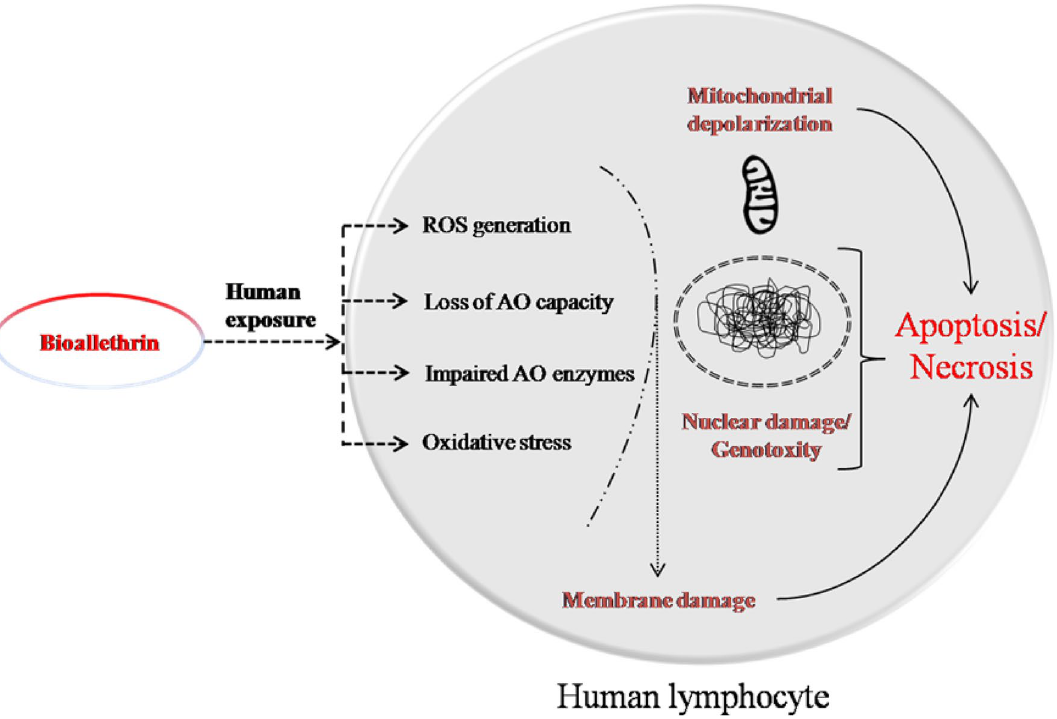
Figure 10. Schematic representation of the effects of bioallethrin on human lymphocytes. ROS reactive oxygen species; AO